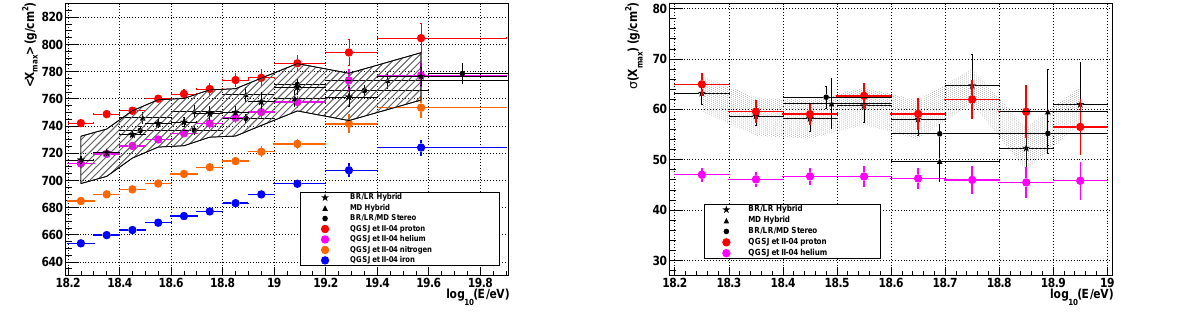
Figure 7: (cid:104) X max (cid:105) and σ ( X max ) for all TA composition measurements that observe air shower X max . QGSJET II-04 predic- tions are for BR / LR hybrid reconstruction.